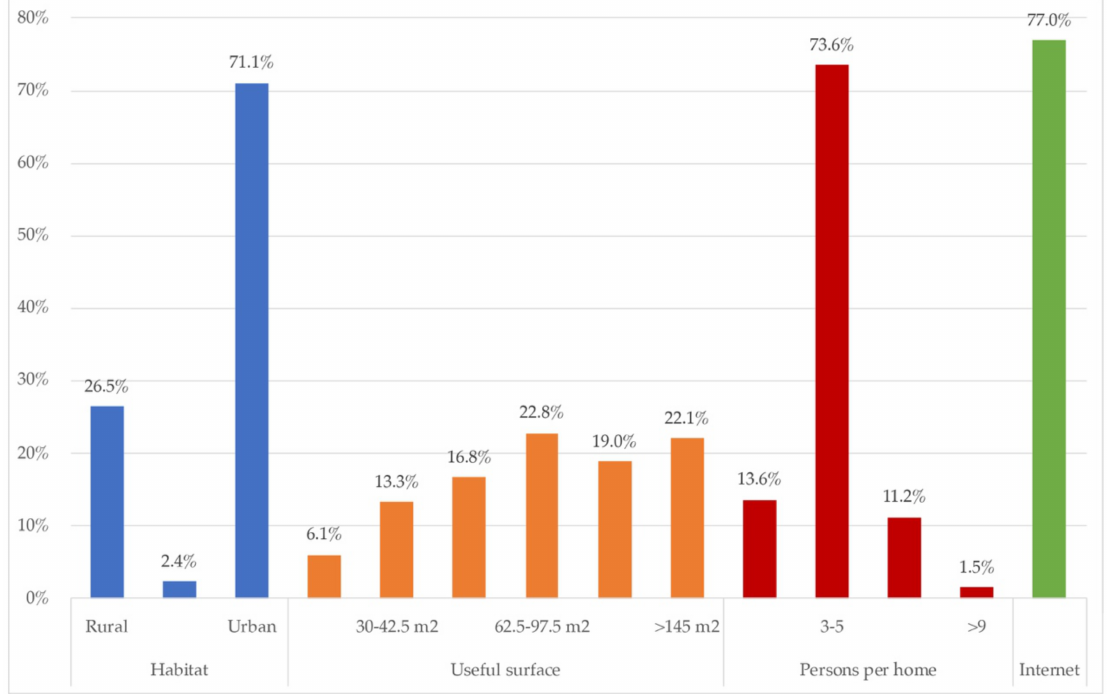
Figure 2. Profile of the households participating in the